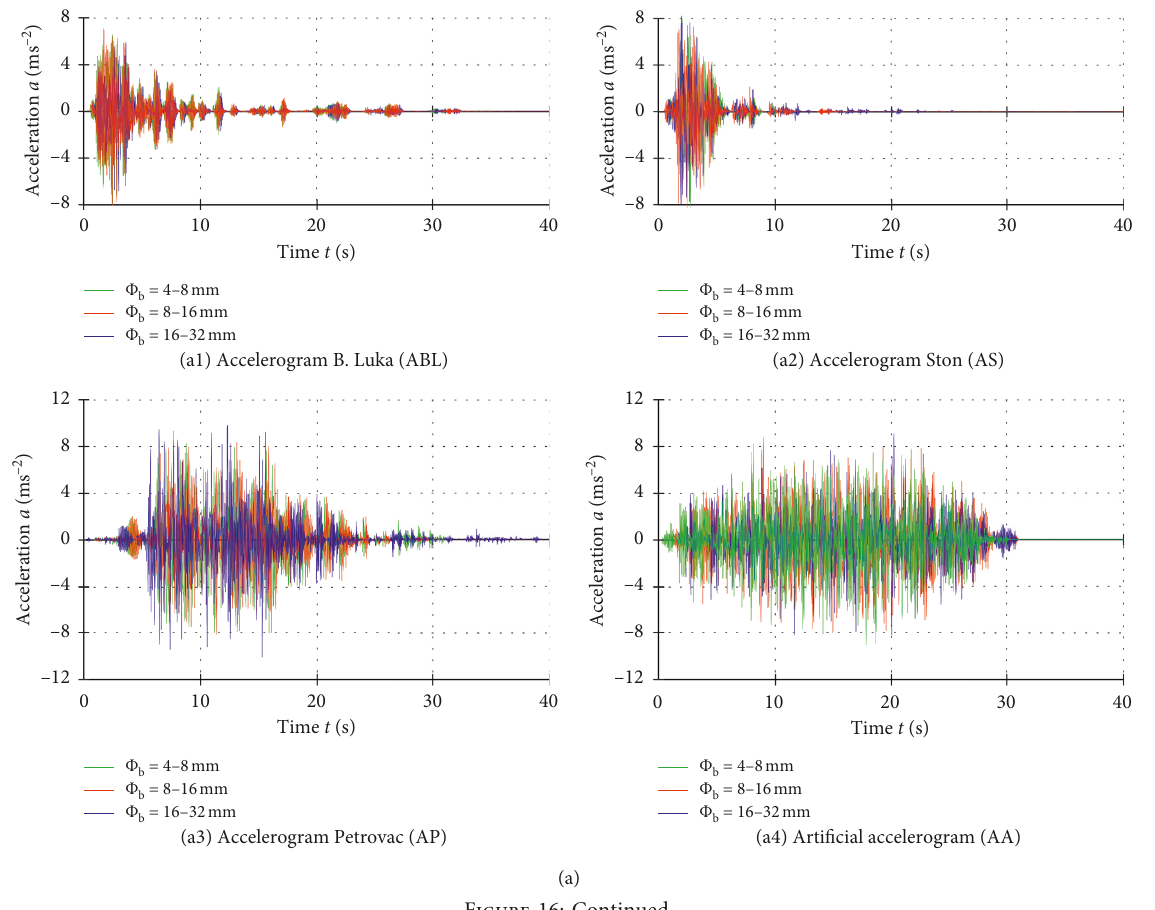
� 0.2g. (b) PGA � 2 . (a) PGA